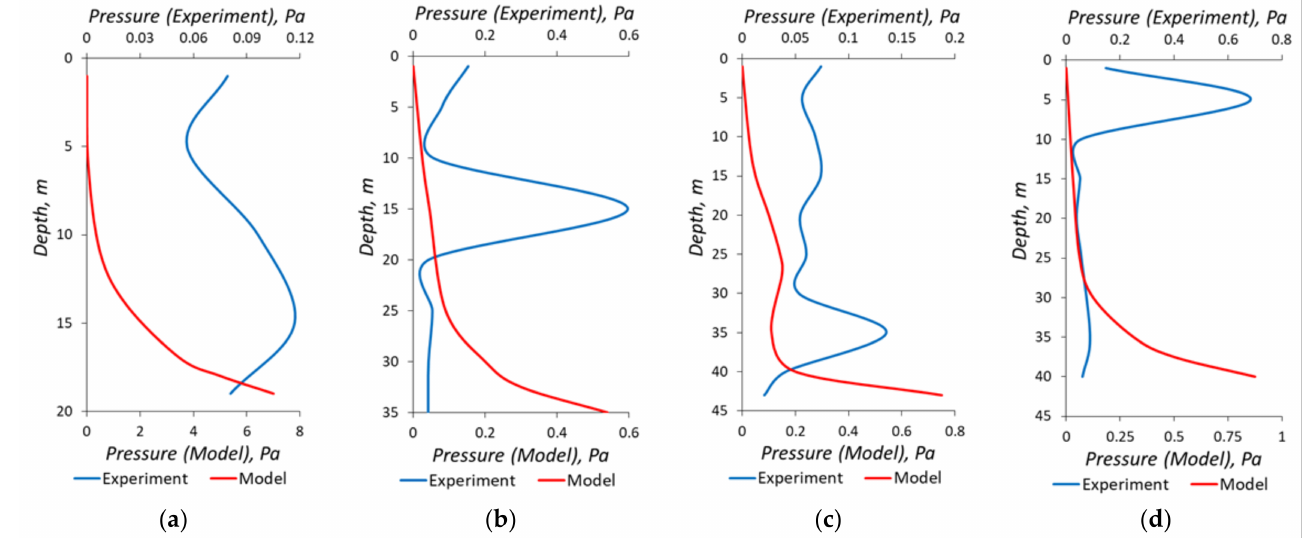
Figure 3. Vertical distributions of the pressure field, measured and calculated by the model at points: ( a ) P1; ( b ) P2; ( c ) P3; ( d )